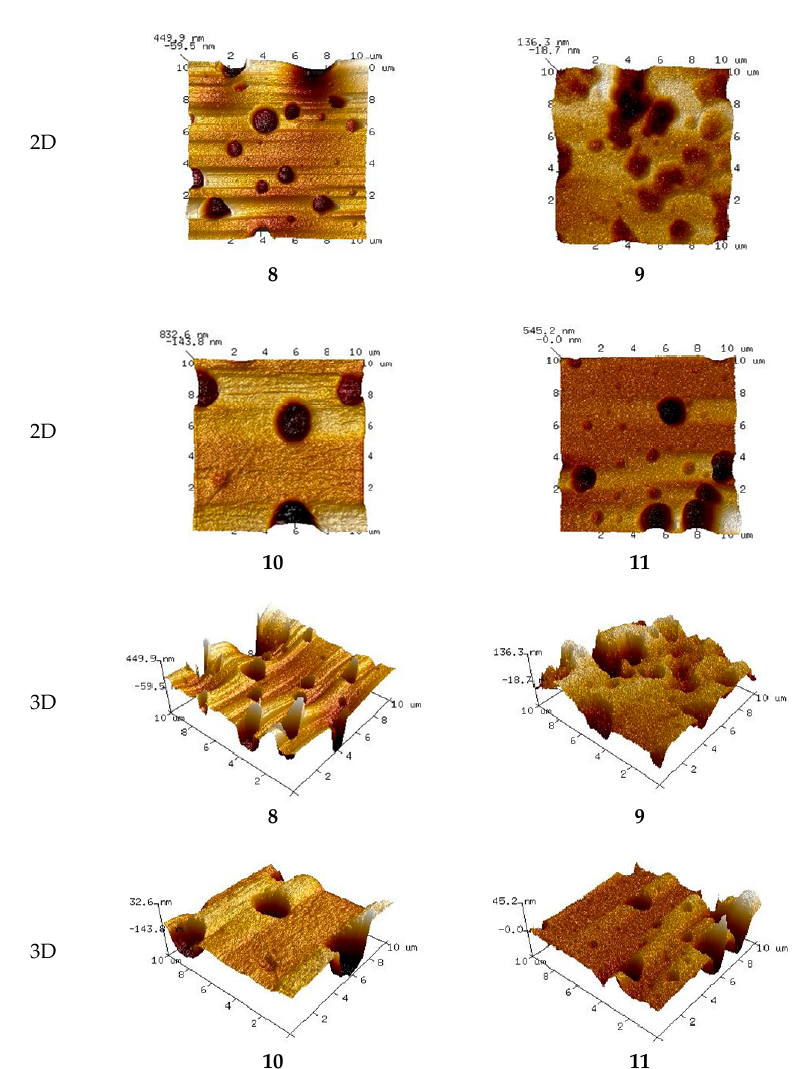
Figure 4. 2D and 3D-atomic force microscopy (AFM) images of PIMs with an increasing percentage of